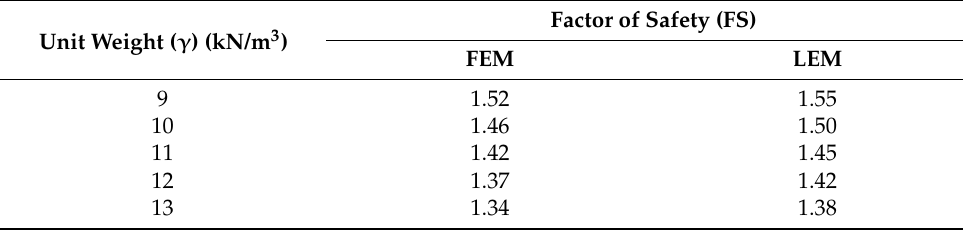
Table 4. Analysis results for different unit weight values.